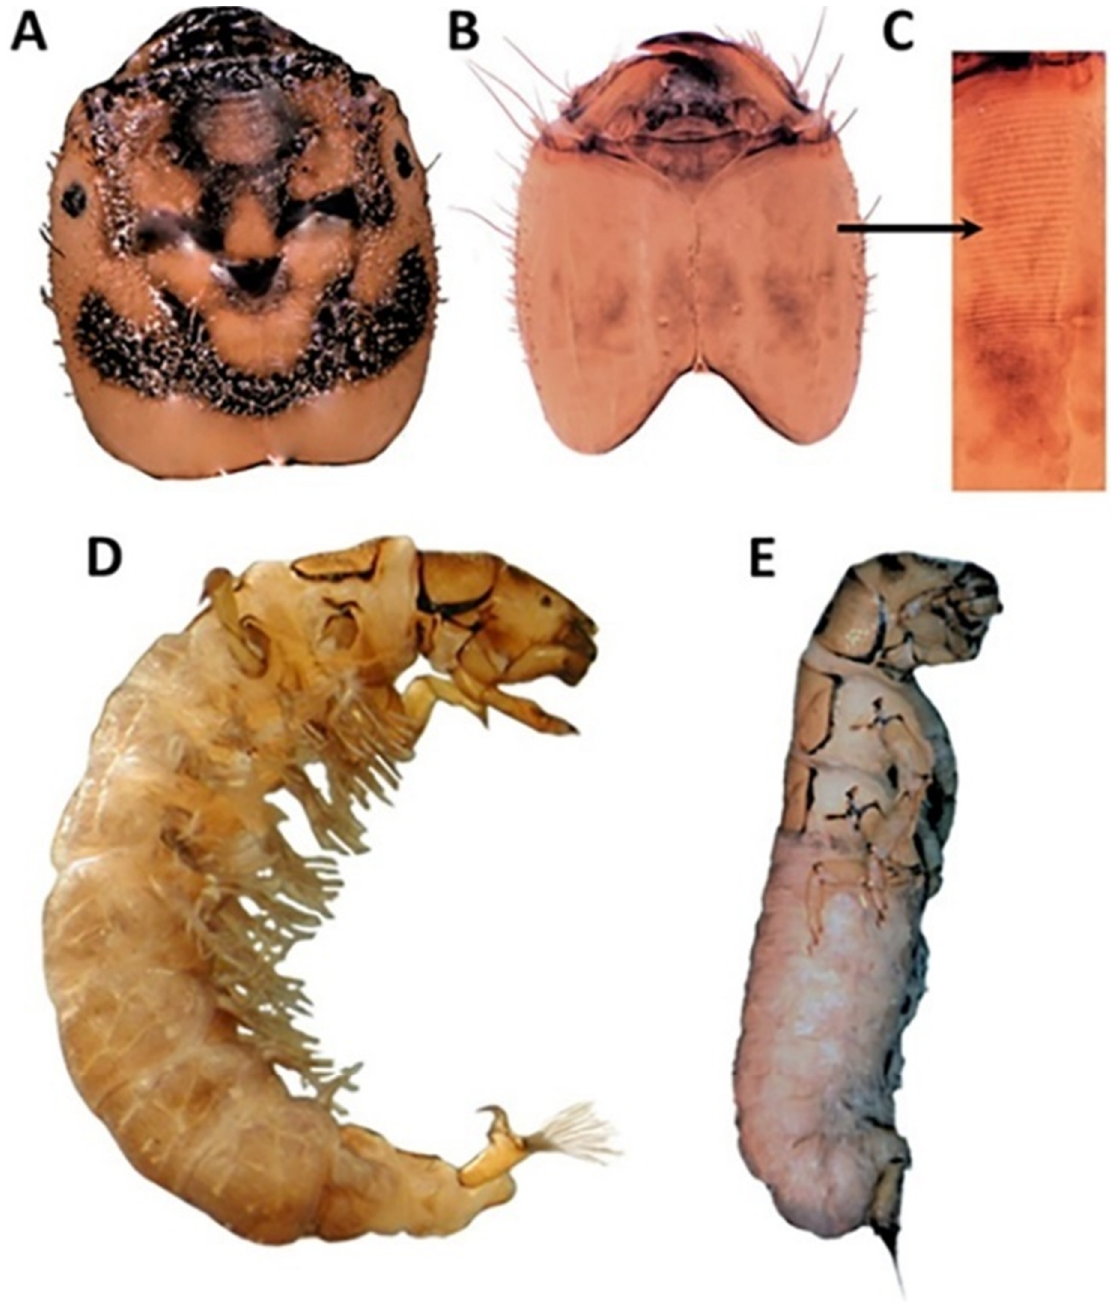
Figure 5. Late-stage larval morphology of Hydropsyche alternans . ( A ) Fifth instar head, dorsal view showing quadrate head shape and markings; ( B ) 5th instar head, ventral view showing large mandibles, sensory sensilla and setae, and stridulatory files; ( C ) high contrast image of left file; ( D ) 5th instar larva; ( E ) pre-pupa.